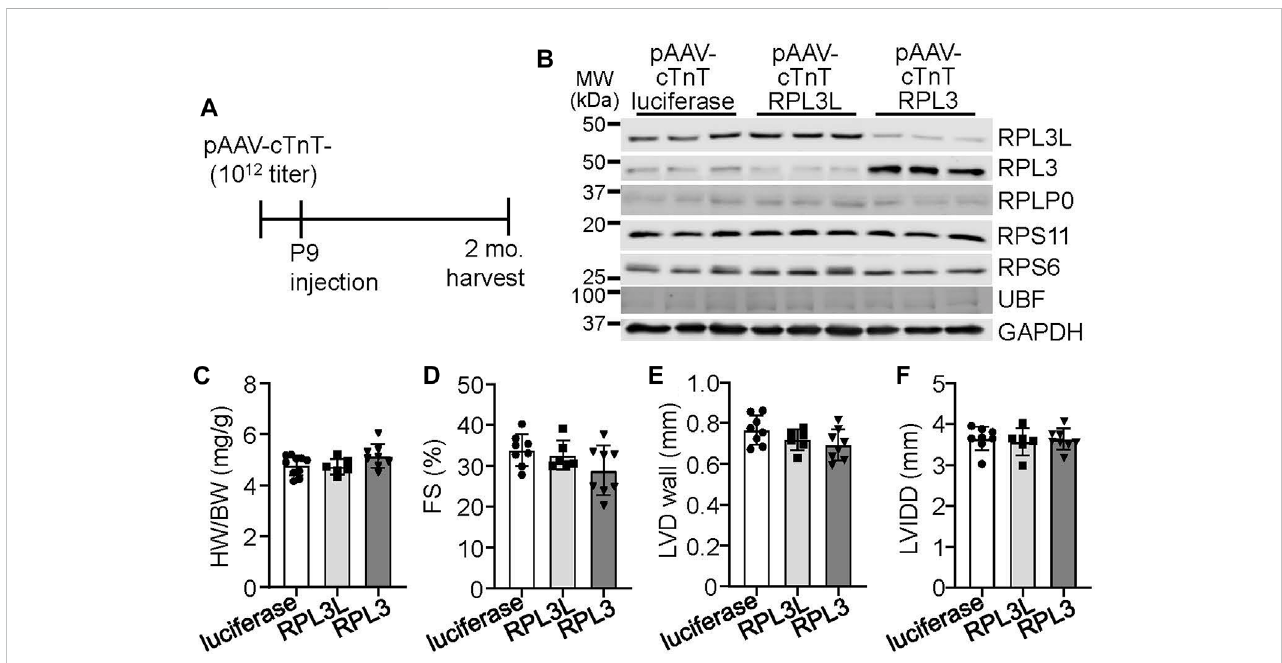
FIGURE 3 Adeno associated virus 9(AAV9)-mediatedoverexpression ofRPL3L and RPL3 doesnot alterheartstructure orfunction. (A) Schematicshowingtimeline ofintrathoracicinjectionsoftherecombinantAAVsencodingluciferase, RPL3L,andRPL3intoP9pupsatatiterof1×10 12 genomecopiesfollowedbyharvest and analysis at 2 months of age. (B) Western blots of the indicated proteins in cardiac ventricles from mice injected with AAV-luciferase, -RPL3L, and -RPL3. GAPDH is used is a loading control ( n = 3 per group). MW denotes molecular weight in kilodaltons (kDa). (C – F) Heart weight-to-body weight ratio (HW/ BW), fractional shortening (FS), average left ventricular wall thickness in diastole (LVD wall) and left ventricular internal dimension in diastole (LVIDD) in mice injected with the indicated AAVs as shown ( n = 6 – 10 per group). Data are mean ± SEM. No statistical differences between the groups of mice were